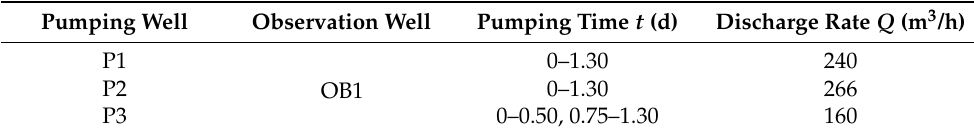
Table 1. Schedule of the pumping test.